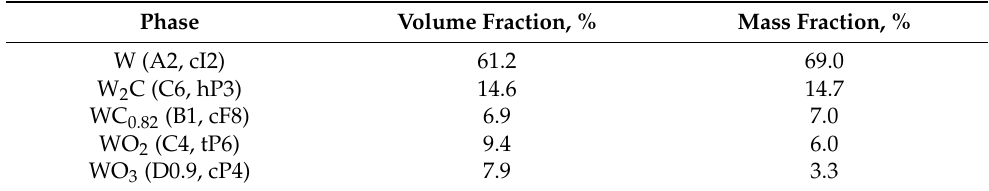
Table 5. Composition of the sample of the «tungsten + nanodiamonds» composite after heating to 720 °C.